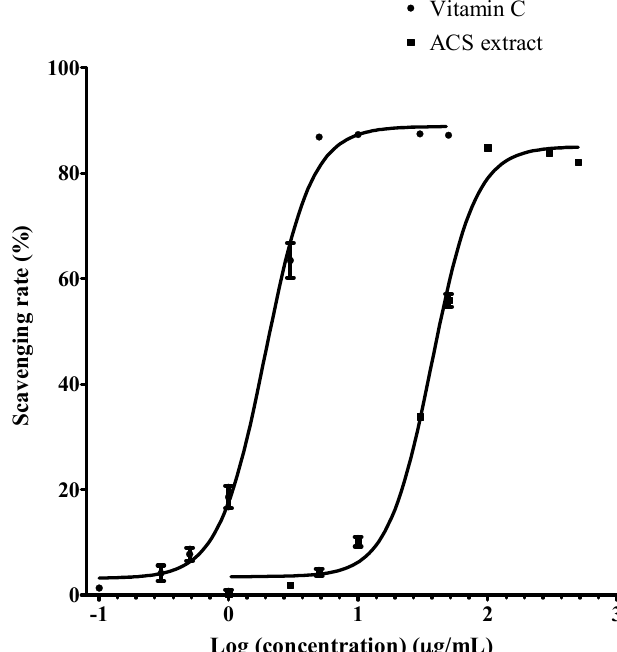
Figure 2. The free radical scavenging capacity of vitamin C and ACS against their concentration [mean ± standard error of mean (SEM), n = 3].